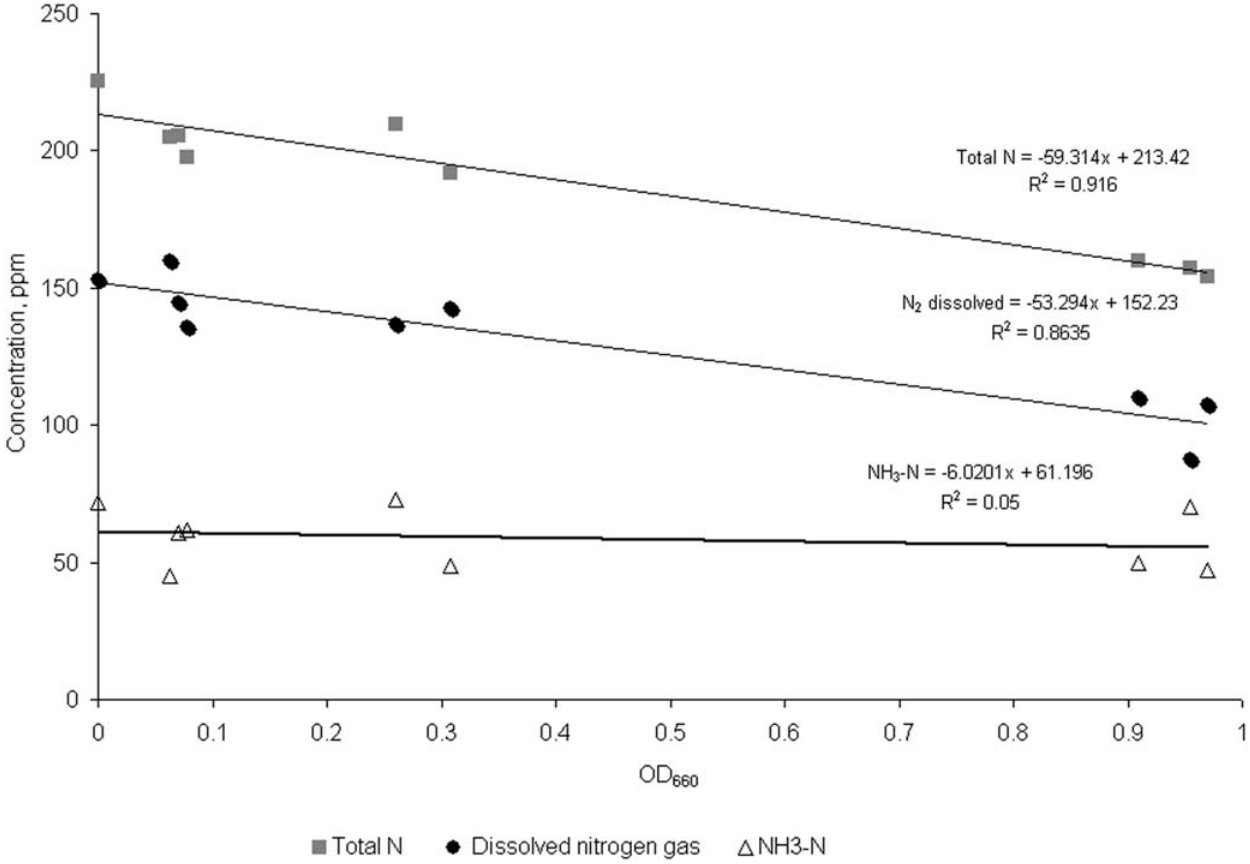
Figure 4. Changes in total nitrogen, ammonium and dissolved nitrogen gas during the benzoate degradation as functions of OD660.